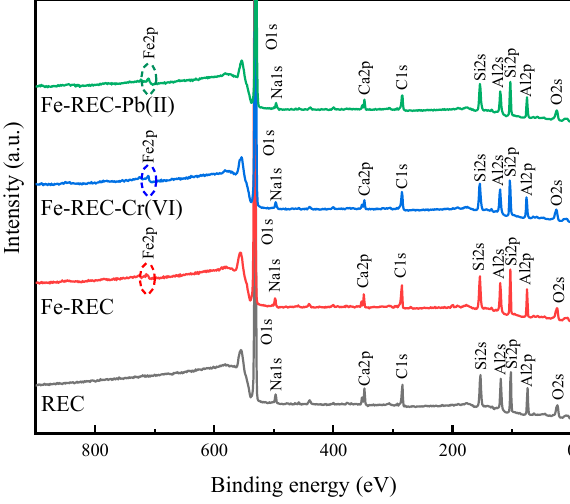
Figure 6. XPS survey spectra of rectorite before after modification and adsorption.